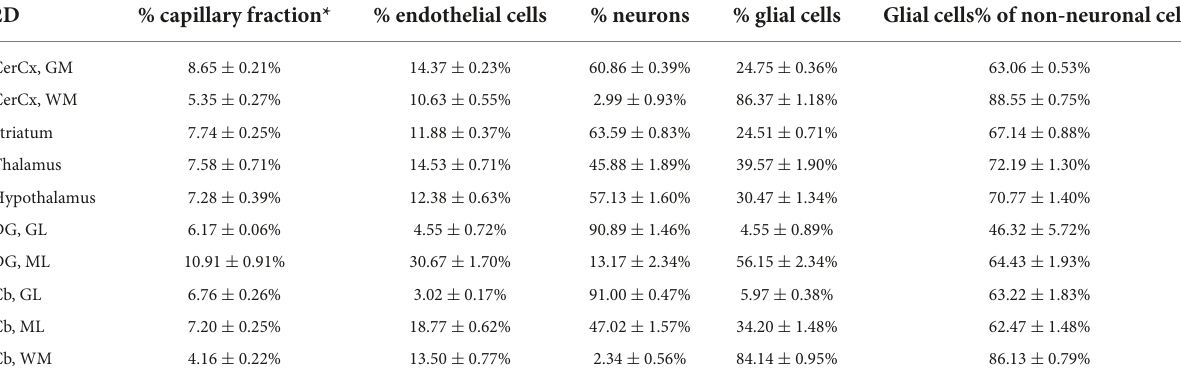
Values correspond tothe average across sites ineach brain structure of three mice(#3, #4 and #5). *Notethat the capillary fraction appears higherhere than when measured in3D due to the deeper focal thickness under the lower magnification used for 2D image acquisition, which artificially inflates the relative capillary fraction. Other values are similar between 2D and